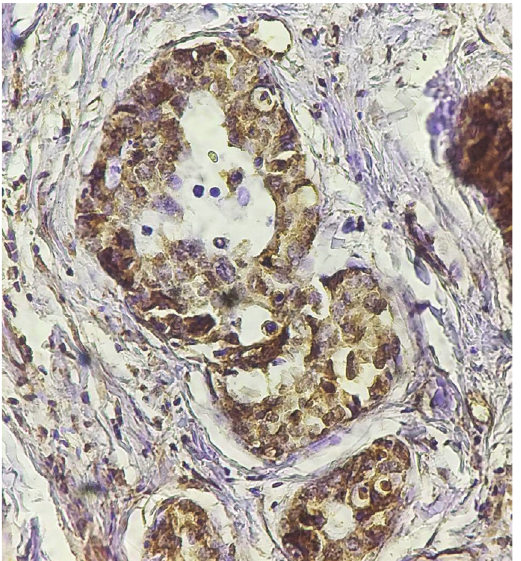
Figure1 . Versican expression as assessed by immunohisto- chemistry in cancerous tissue